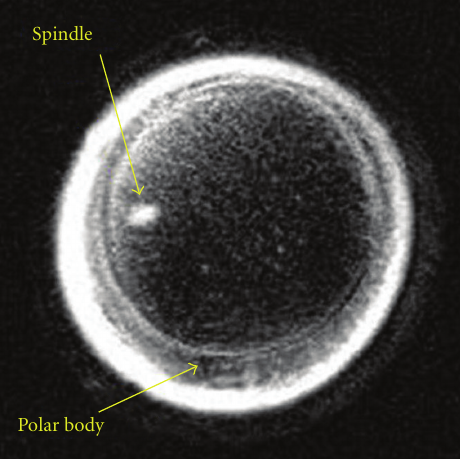
the oocytes in which the spindle was rebuilt/visualized it was detected in a new location and not at the initial place, indicating that the spindle and the polar body move relative to each other. Our observation provides further evidence of that using recently developed cryopreservation protocols both the capability of meiotic spindle for repolymerization and the original microtubule structure of the spindle can be maintained in high